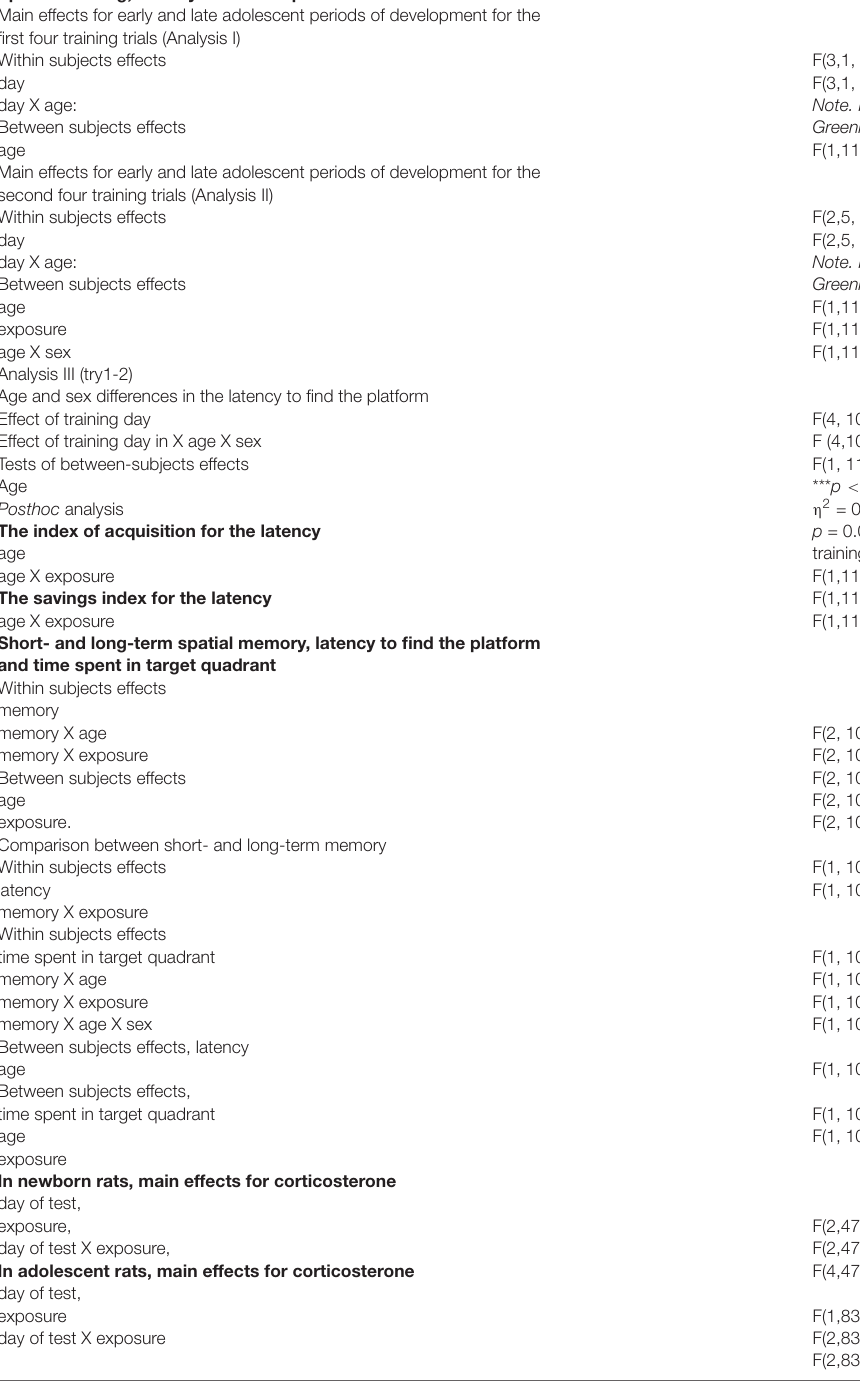
TABLE 1 | Details of the statistical analyses. Spatial learning, latency to find the platform Main effects for early and late adolescent periods of development for the first four training trials (Analysis I) Within subjects